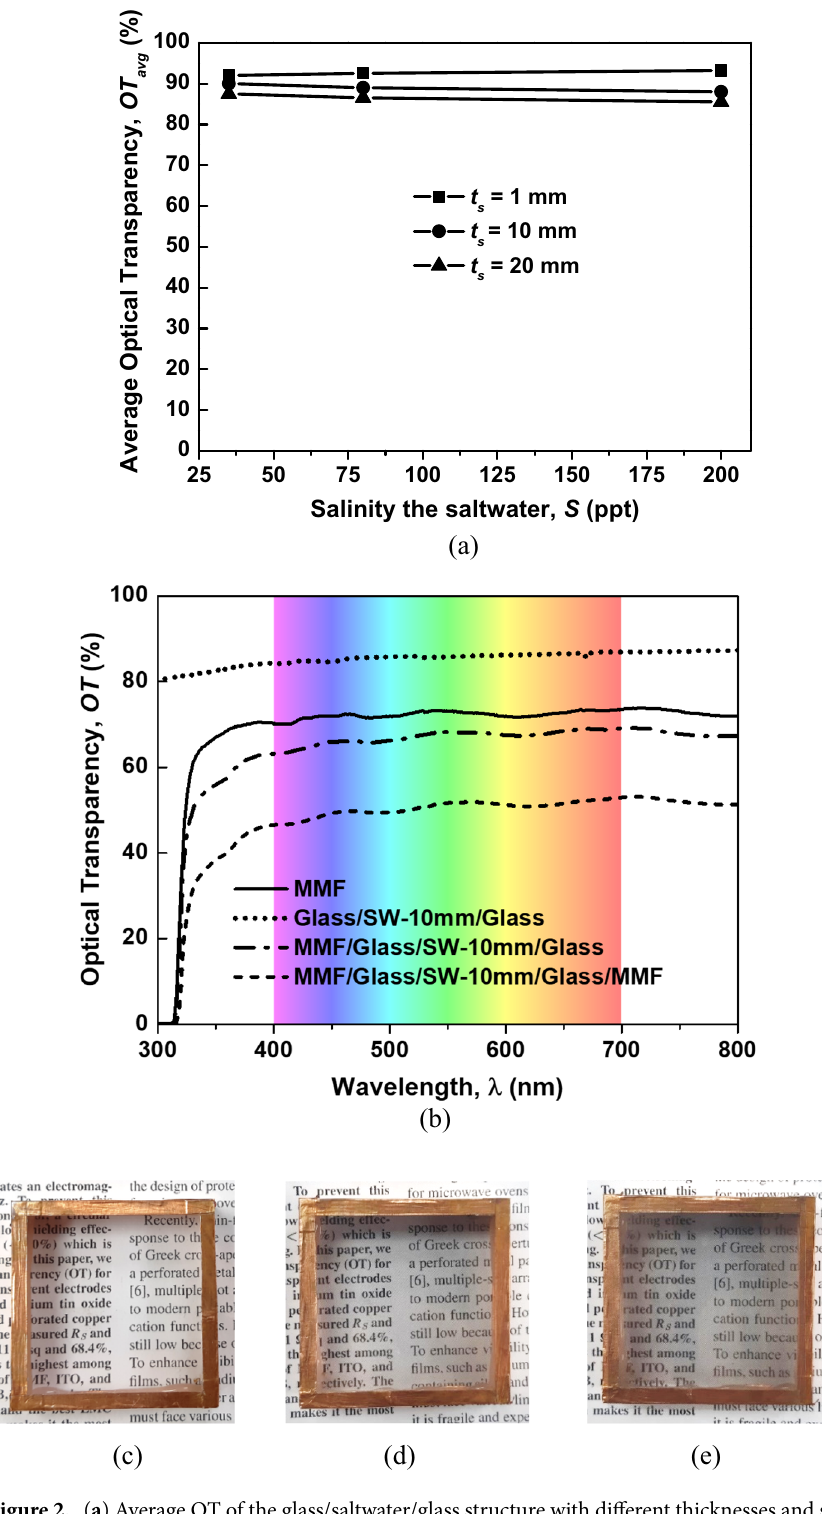
Figure 2. ( a ) Average OT of the glass/saltwater/glass structure with different thicknesses and salinities of the saltwater layer; ( b ) optical transparency spectra of transparent electrodes and structures in the visible range; real pictures of the TEs over texts ( t s = 10 mm): ( c ) glass/saltwater/glass, ( d ) MMF/glass/saltwater/glass, and ( e )